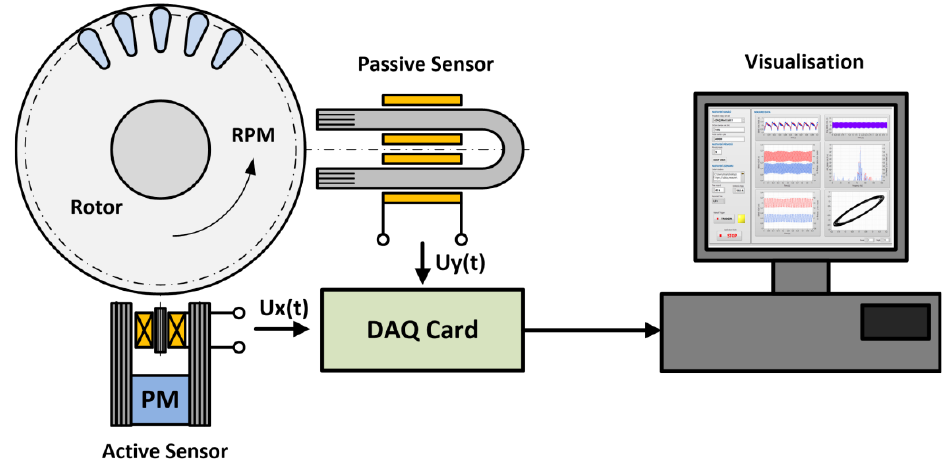
Figure 3. Basic configuration of the measuring system with two independent sensors.